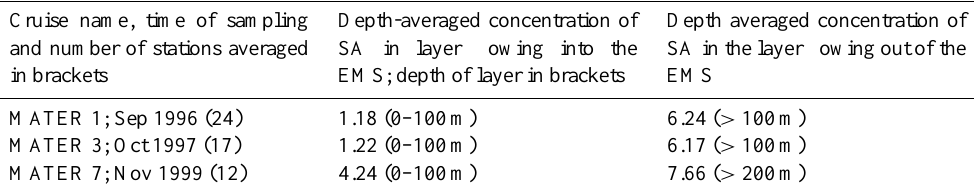
Table 3. Table of calculated fluxes of silicic acid and BSi through the Straits of Sicily; see the text for detailed information of the assumptions made in each particular calculation. The values in bold were used in the total silica budget for the EMS (Table 4). All fluxes in units of 10 9 × molSiyr − 1 Inflow Net inflow Outflow Net flux Chemical species silicic acid BSi silicic acid Total annual flux assuming summer values for silicic acid and an average of 1µmol BSi L − 1 in the photic zone for the entire year. Calculated summer flux (6 months) using sum- mer values for silicic acid and 1µmol BSi L − 1 with 40% of the total annual flow (Astraldi et al., 1999). Calculated winter (6 months) using winter (Nov 103 103 174 71 1999) silicic acid values and with 60% of the total annual flow (Astraldi et al., 1999). Calculated total annual fluxes summing winter 121 16 137 264 and summer values.